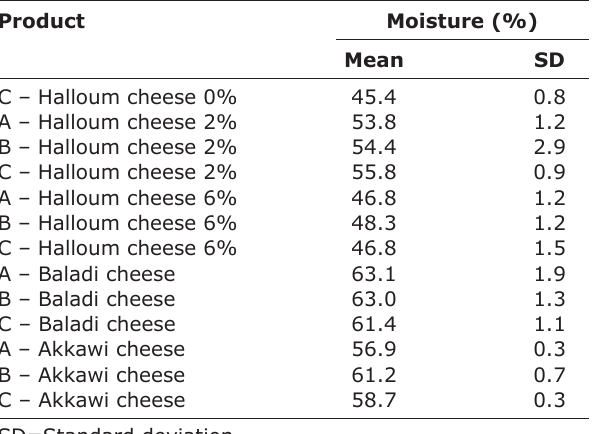
Table-4: Mean moisture content (±standard deviation) of Baladi, Akkawi, and Halloum from the three treatments (A, B, and